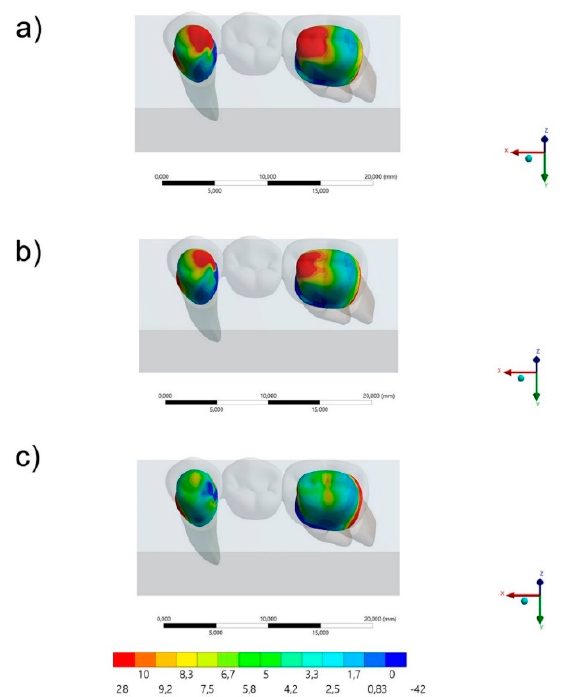
Figure 4. Occlusal view of the Maximum principal stress maps in the cement layer for each group: ( a ) AR, ( b ) PEEK and ( c ) RC.